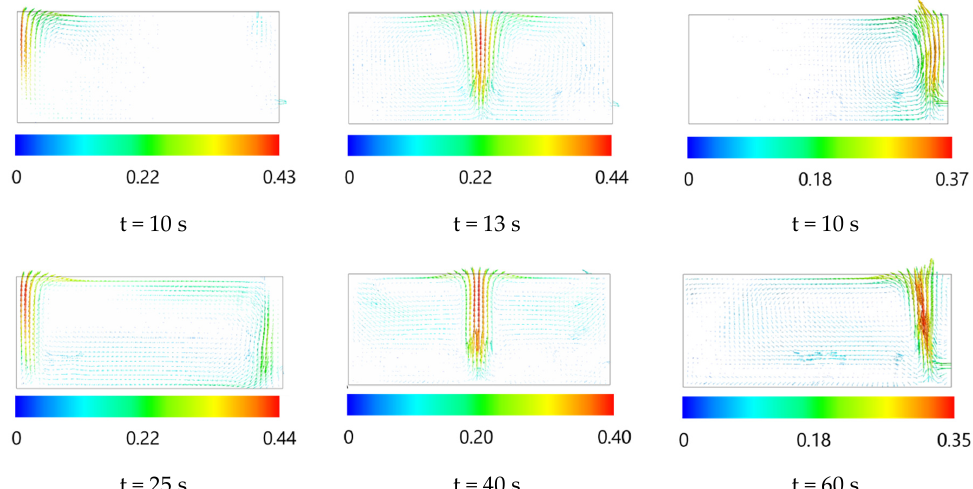
Figure 5. Velocity vectors for Model 1 (left), Model 2 (middle), and Model 3 (right) whilst the envelope of 1% mole fraction of hydrogen was rising to the ceiling (up) and filling the whole ceiling (down) (m/s).